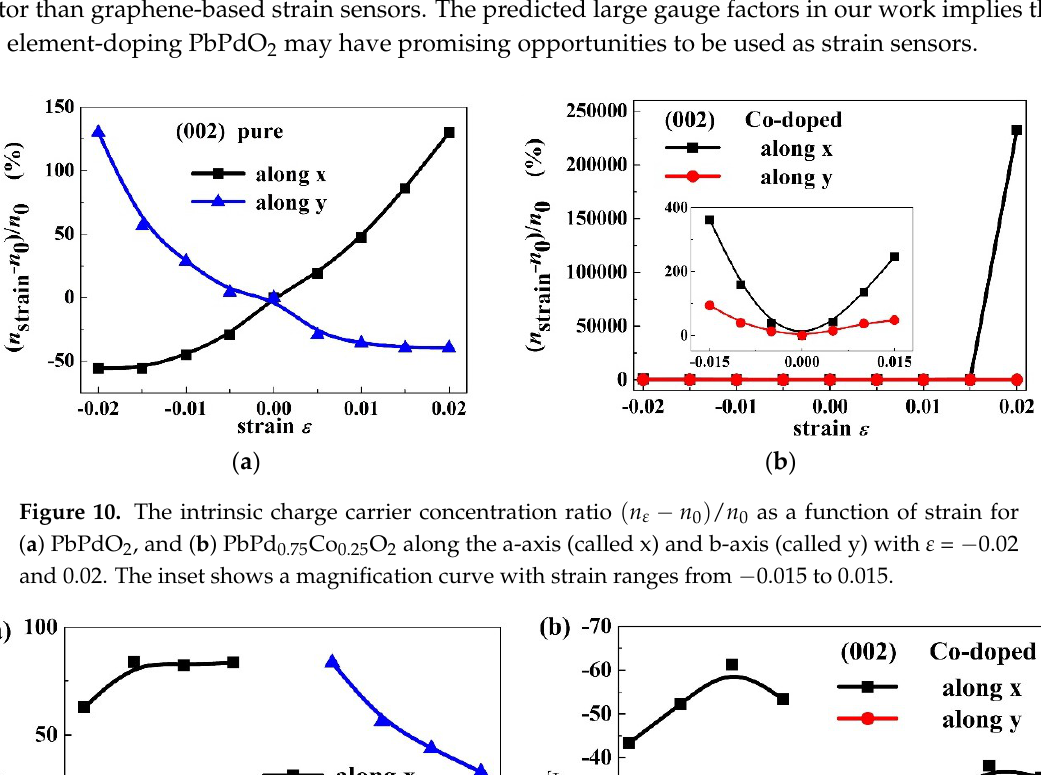
)/ n n n  ( as a function of strain for ( a ) 0 0   = −0.02 and